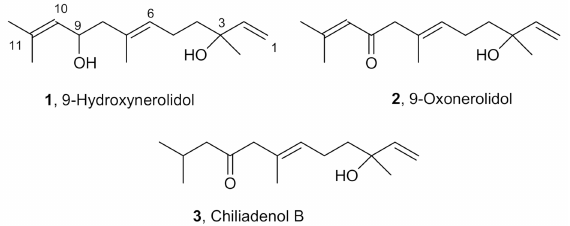
Figure 3. Structures of 9-hydroxynerolidol, 9-oxonerolidol, and chiliadenol B ( 1 – 3